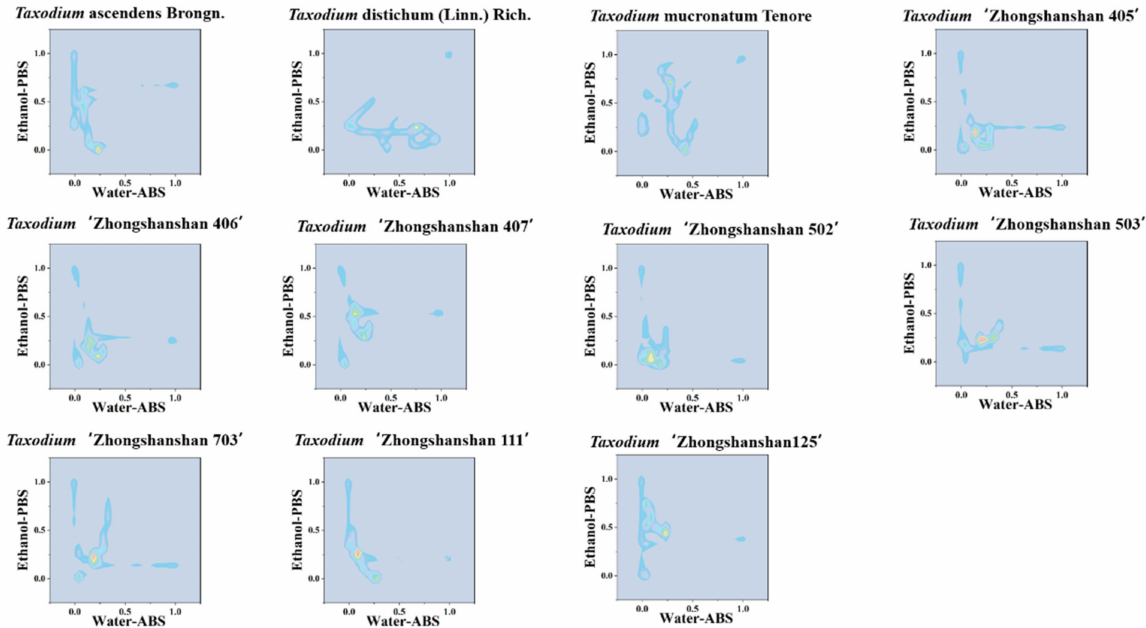
Figure 4. Two-dimensional density map of T. ascendens, T. distichum, T. mucronatum, T. ‘Zhongshanshan 405’, T. ‘Zhong- shanshan 406’, T. ‘Zhongshanshan 407’, T. ‘Zhongshanshan 502’, T. ‘Zhongshanshan 503’, T. ‘Zhongshanshan 703’, T. ‘Zhongshanshan 111’, and T. ‘Zhongshanshan 125’ combining the signals collected under ABS for the water extracts and under PBS for the ethanol